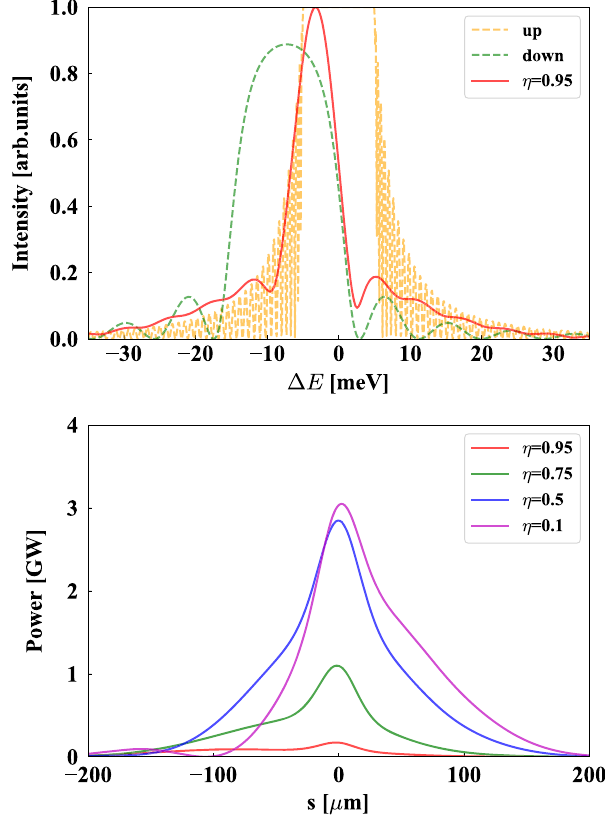
FIG. 12. The spectrum of XFELO pulse is shown in the top plot where η is 0.95. The Bragg reflectivity as a function of photon energy for downstream mirror C 4 (green) and upstream mirror C 1 (orange) is presented by dash lines. Shifts in the spectrum and reflectivity can be found. The power profile for each η is shown in the bottom plot. The maximum peak power exceeds 3